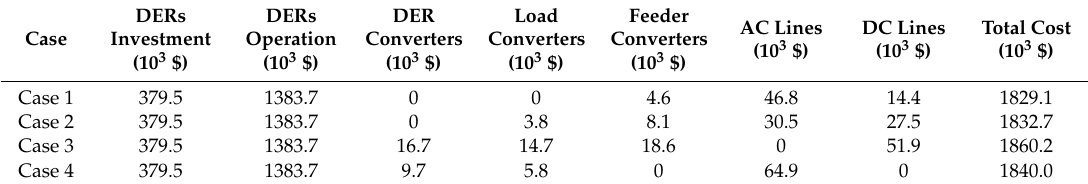
Table 9. Detailed Annual Investment and Operation Costs of the Four Cases.